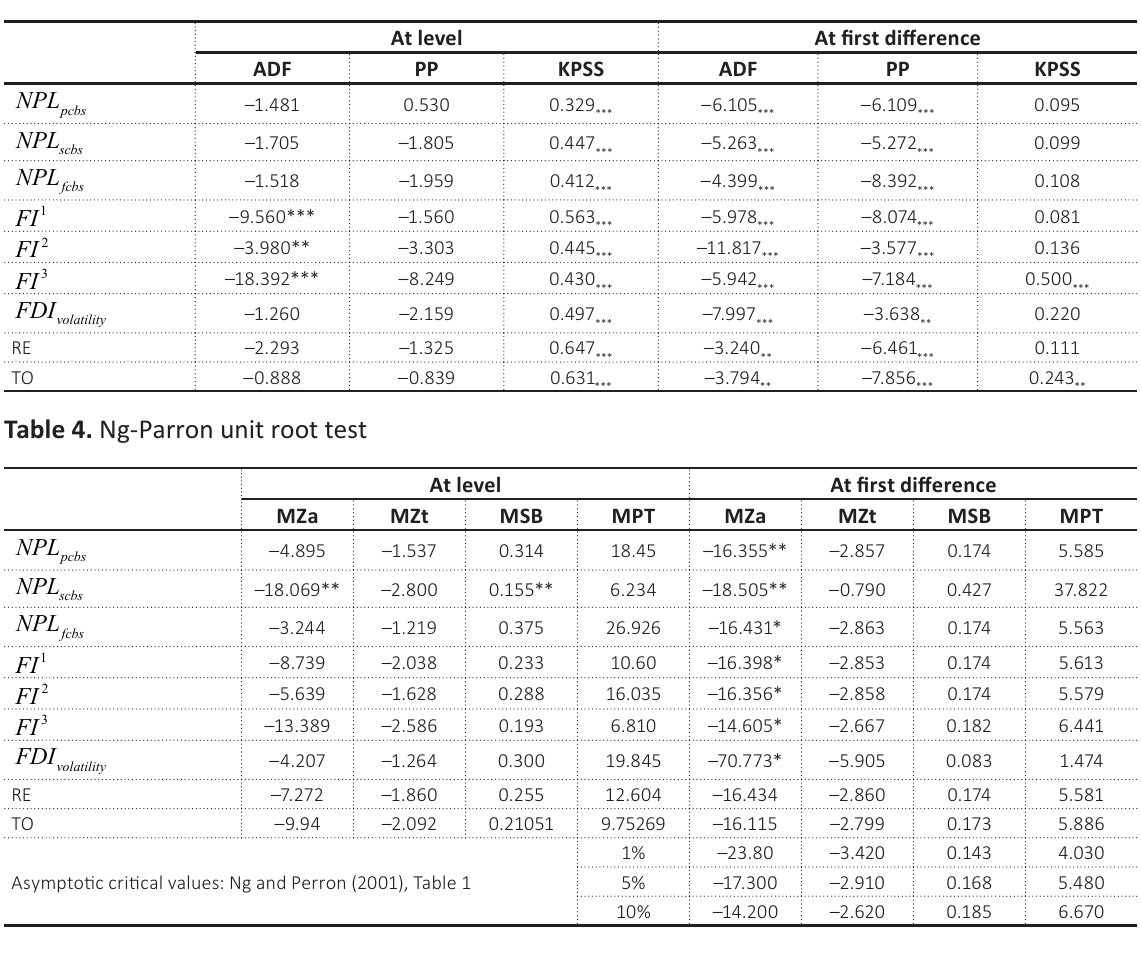
Table 3. Unit root test results